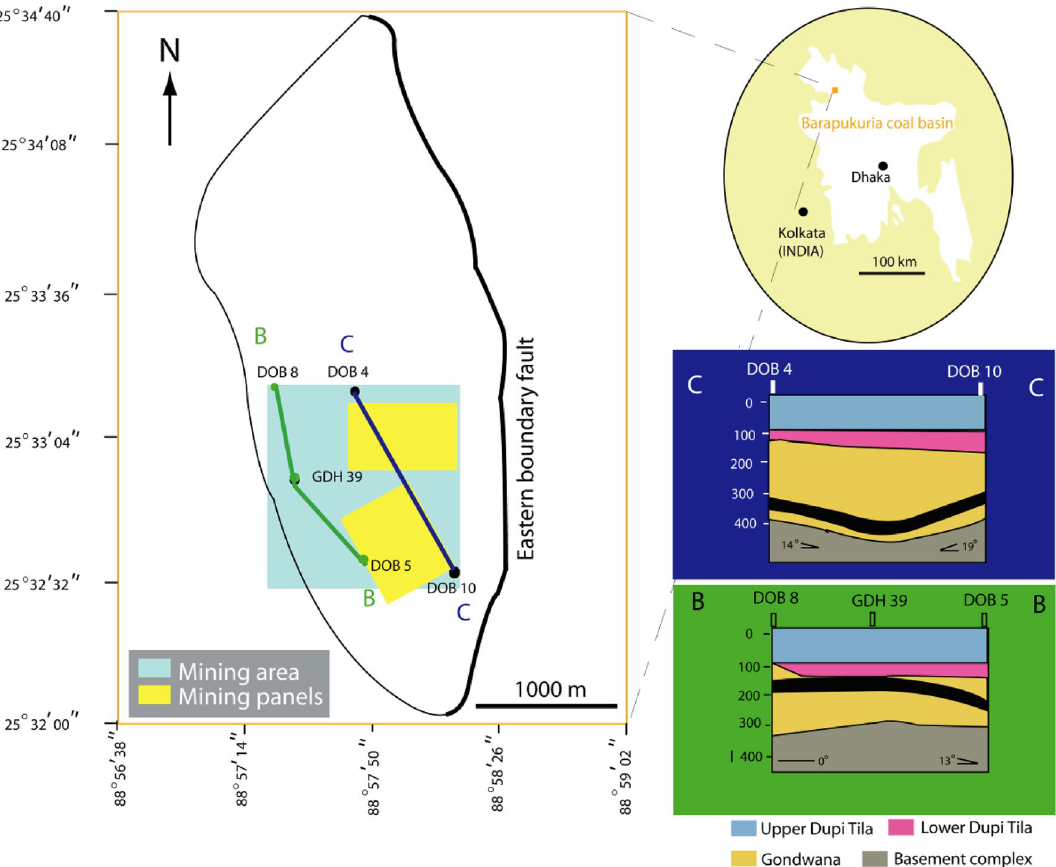
Figure 3. ( a ) Barapukuria coal basin and the areal extent of mining and ( b ) the associated rock layers with the thickest coal seam. (Modified after Armstrong 19 ). (Rockworks20, https:// www. rockw are. com/ produ ct/ rockw orks/#; Abobe Illustrator 10, https:// www. adobe. com/ produ cts/ illus trator.